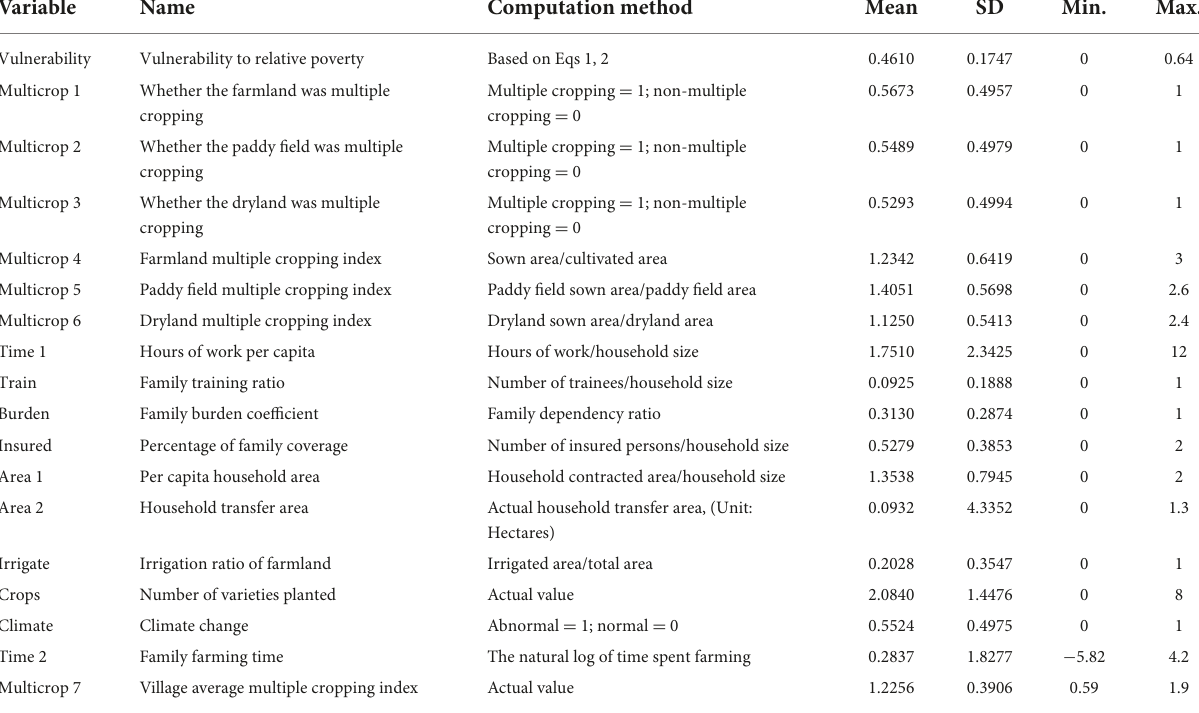
TABLE 1 Descriptive statistics of all